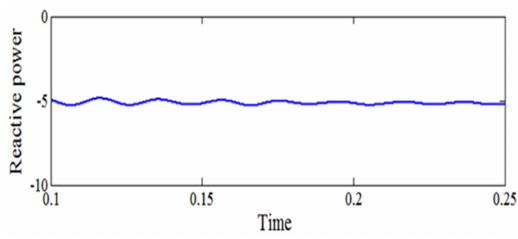
Figure 37. Reactive power from generation.